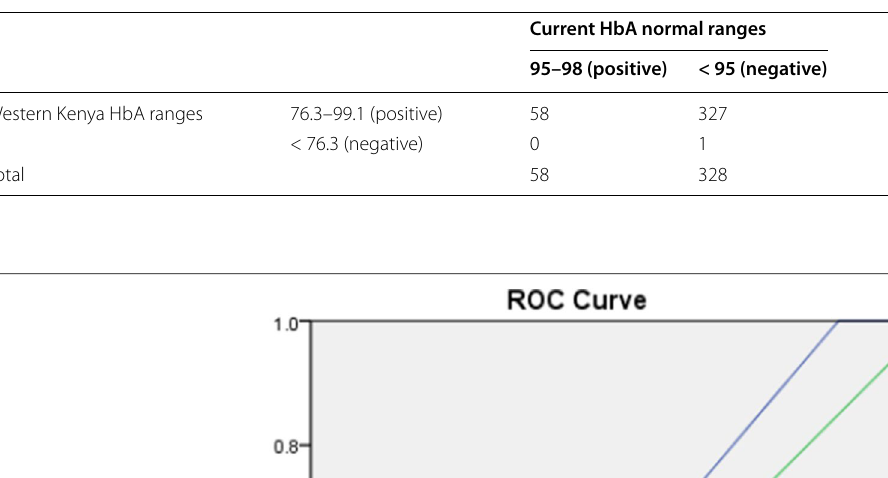
its ability to categorize healthy population as outline on Table 2. Hemoglobin A2 (HbA2) confidence intervals for hemoglobinopathy‑free patients in western Kenya Similarly, hemoglobin A2 (HbA2) varied significantly ( p < 0.0001) with the stations from where the samples were collected with Busia recording HbA2 median of 3.2, IQR 1.03; 95% CI 1.14–5.26, while Bungoma There was no statistical significance ( p = = had a median of 3.3, IQR 0.5; 95% CI 2.3–4.3. These gender with males having a median of 3.0, IQR = = were the highest among the rest of the stations in west- 95% CI 1.8–4.2, while females had the same median = ern Kenya, together with Kitale that had HbA2 medians and interquartile range, thus sharing the same cutoff value.